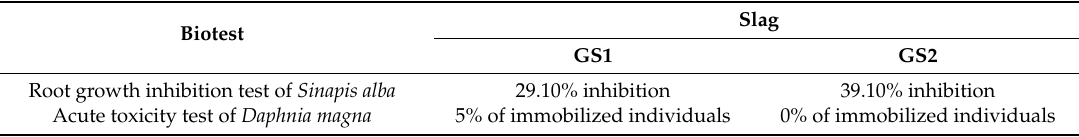
Table 5. Ecotoxicological test results of granulated slag from gray iron